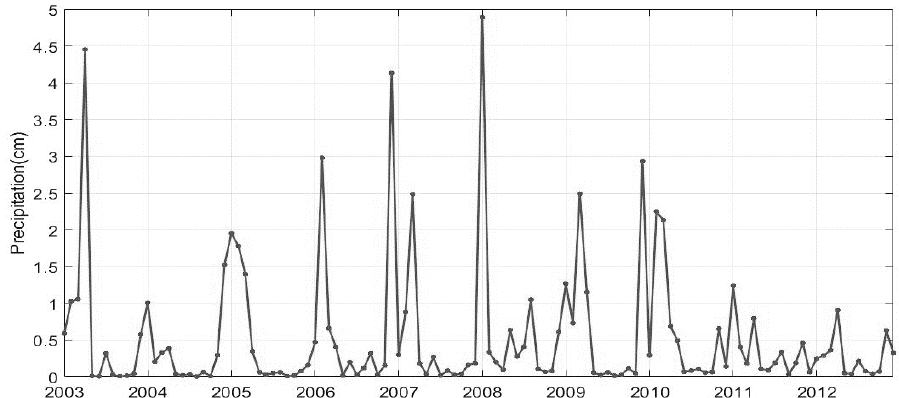
Figure 14. Precipitation time series obtained from TRMM from 2003 to 2013.